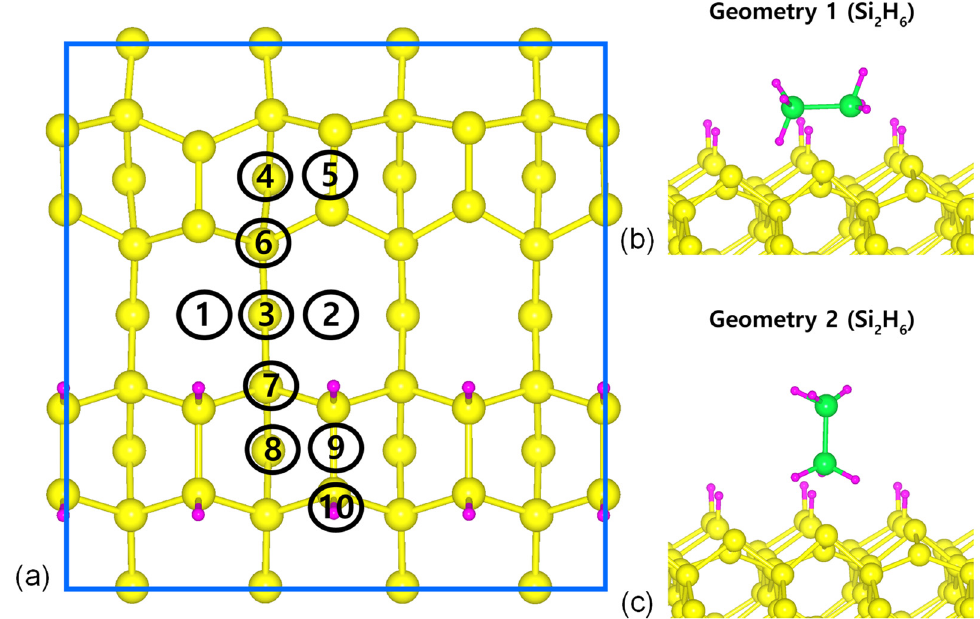
Figure 3. Two geometries and 10 positions of Si 2 H 6 on the H-50% covered Si(001)-(4 × 4) surface. Solid lines and numbers represent the (4 × 4) unit cells and the molecules adsorption sites, respectively. ( a ) 10 positions; ( b ) Geometry 1; ( c ) Geometry 2.